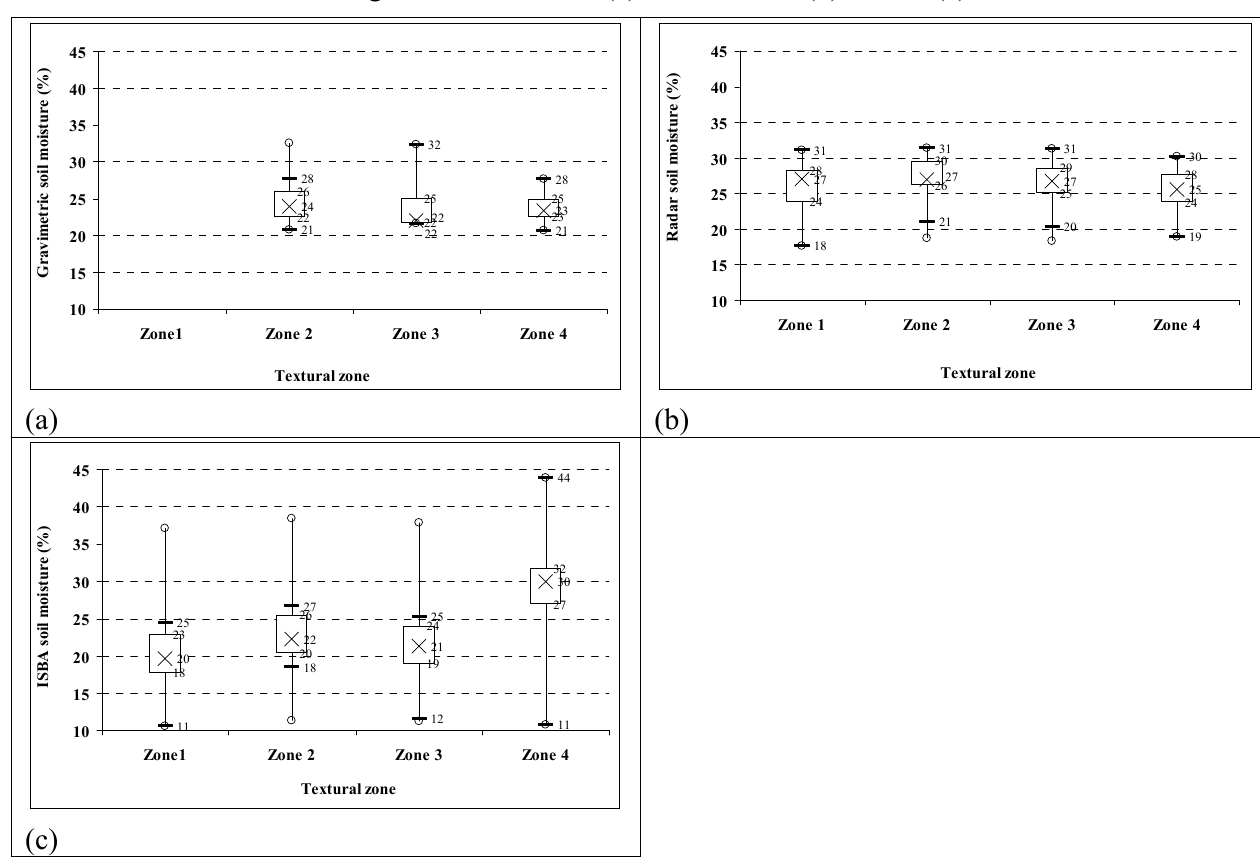
Figure 9. Box plot comparing the results obtained for soil moistures according to textural zones. (a) Gravimetric, (b) Radar, (c) ISBA.